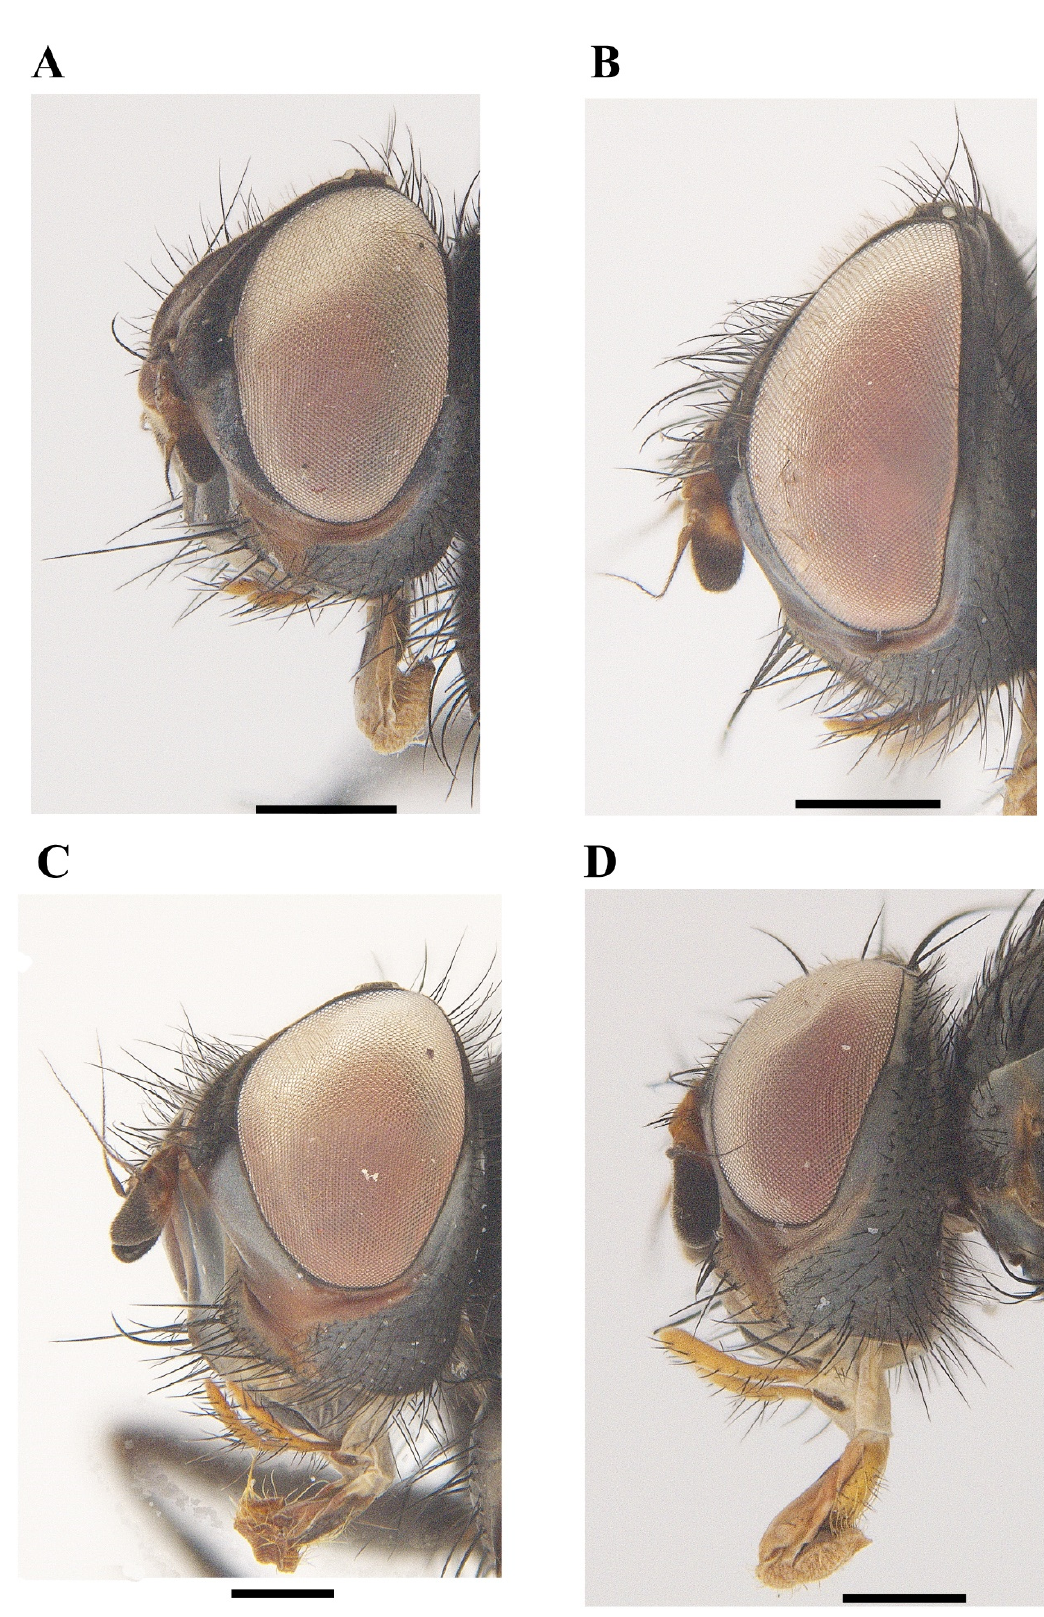
Figure 2. Lateral view of Macquartia spp. heads. ( A ) M. brunneisquama sp. nov. ( B ) M. chinensis sp. nov. ( C ) M. flavipedicel sp. nov. ( D ) M. flavifemorata sp. nov. Scale bar = 0.5 mm.